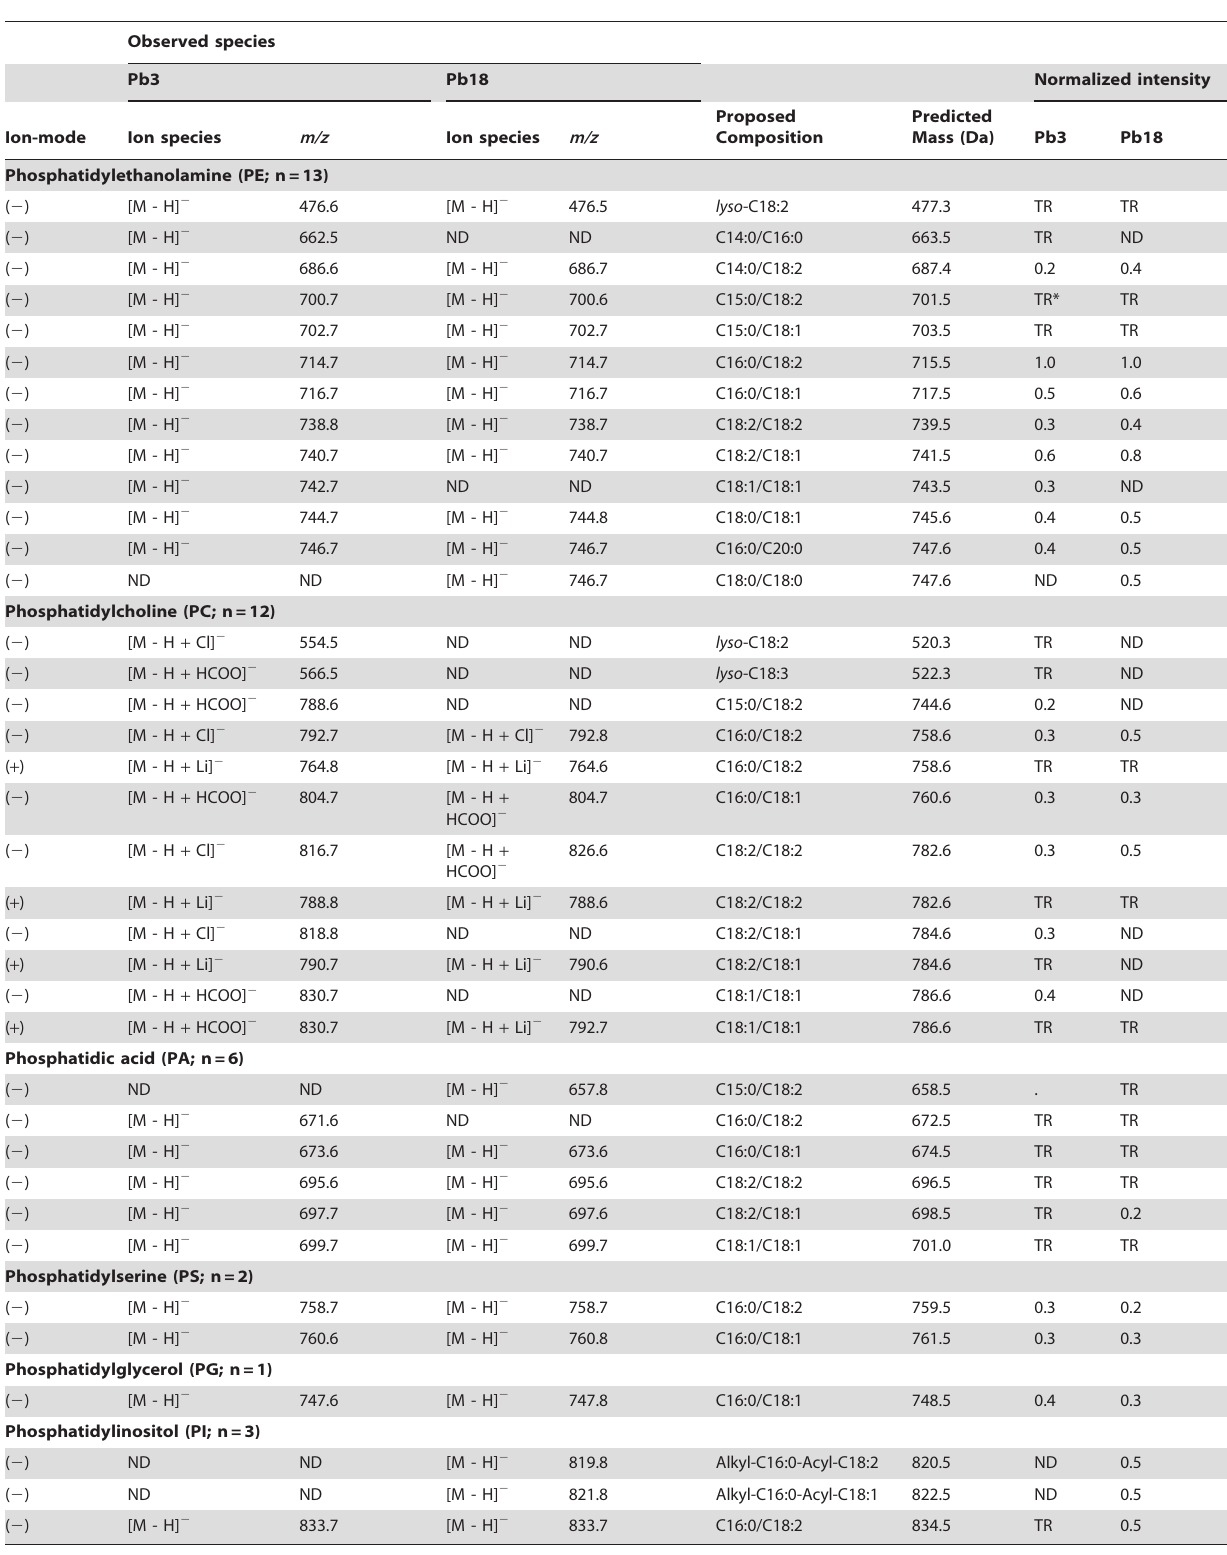
Table 1. Composition of major phospholipids identified by ESI-MS total-ion mapping from Pb3 and Pb18 vesicles.